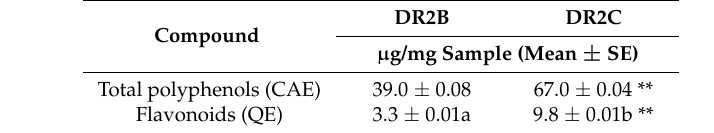
Table 1. Amounts of total polyphenols and flavonoids in DR2B and DR2C extracts ( n =